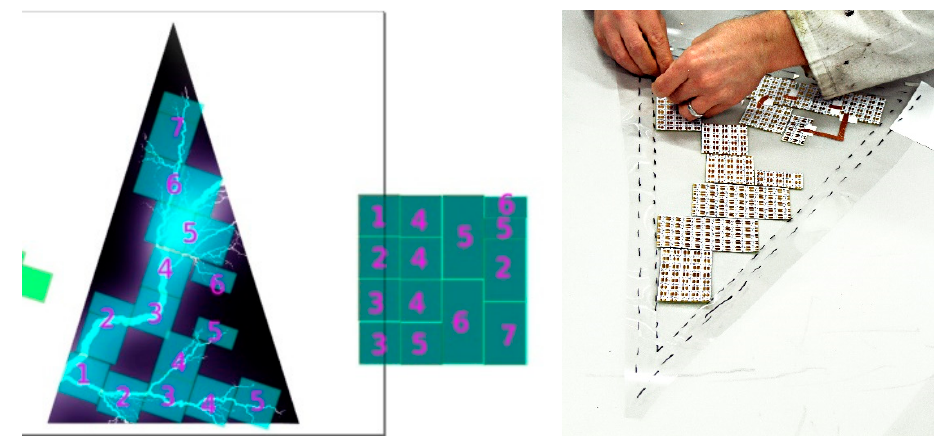
Figure 6. Arrangement and sequencing of